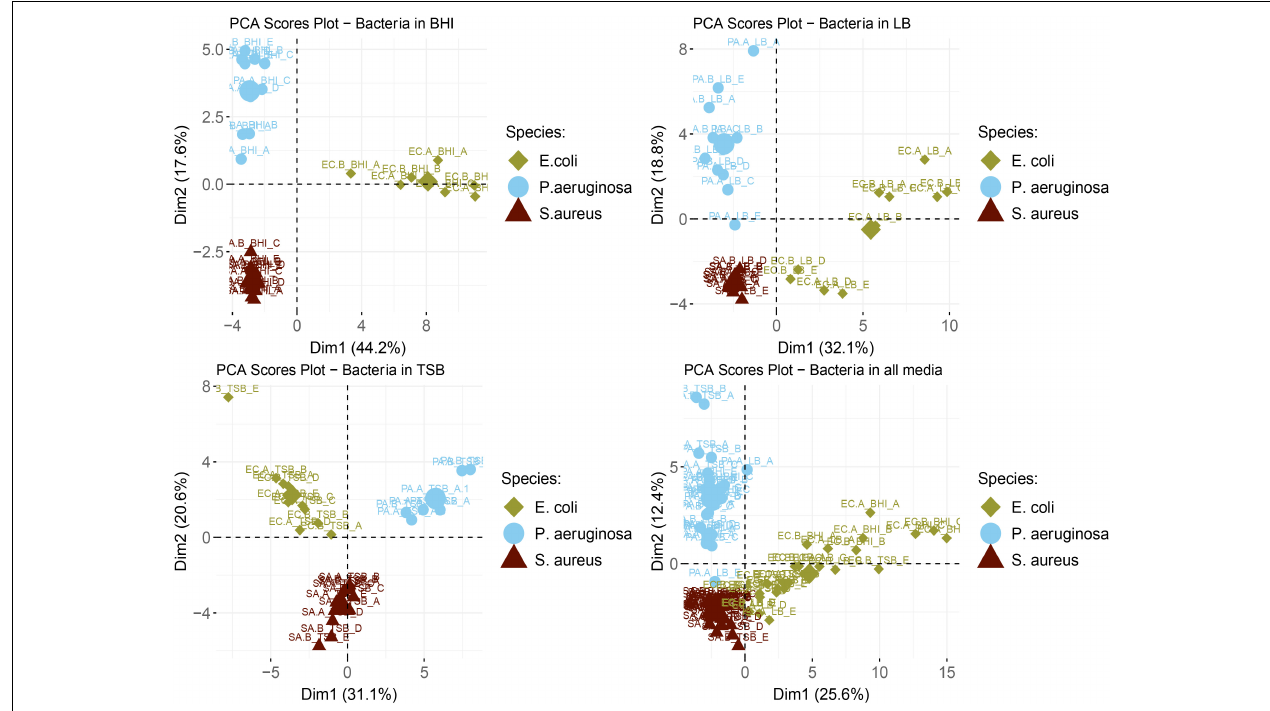
FIGURE 1 | Labeled scores plot representations of scores from the PCA analyses of bacterial samples in BHI (top left), LB (top right), TSB (bottom left), and all examined media (bottom right). The large symbols in each plot are the geometric means for each species. The corresponding strain names to the abbreviated titles of the bacterial samples shown in this plot are as follows: EC.A: E. coli DSM103372, EC.B: E. coli DSM30083, PA.A: P. aeruginosa DSM105372, PA.B: P. aeruginosa DSM25642, SA.A: S. aureus DSM2569, SA.B: S. aureus